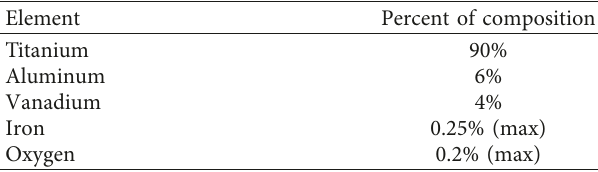
Figure 2: Schematic of E-Drill ™ with jig and locator (a) and cross-sectional view of fastener post cut (b). Table 1: Titanium chemical composition.